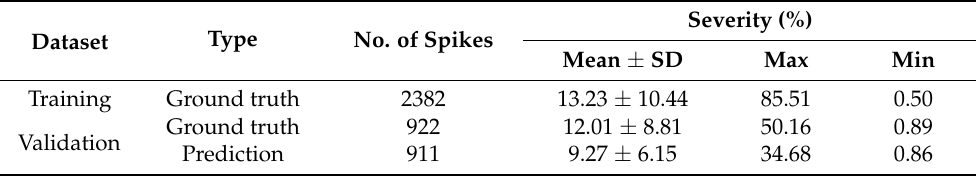
Table 4. Statistical results of wheat spike FHB disease